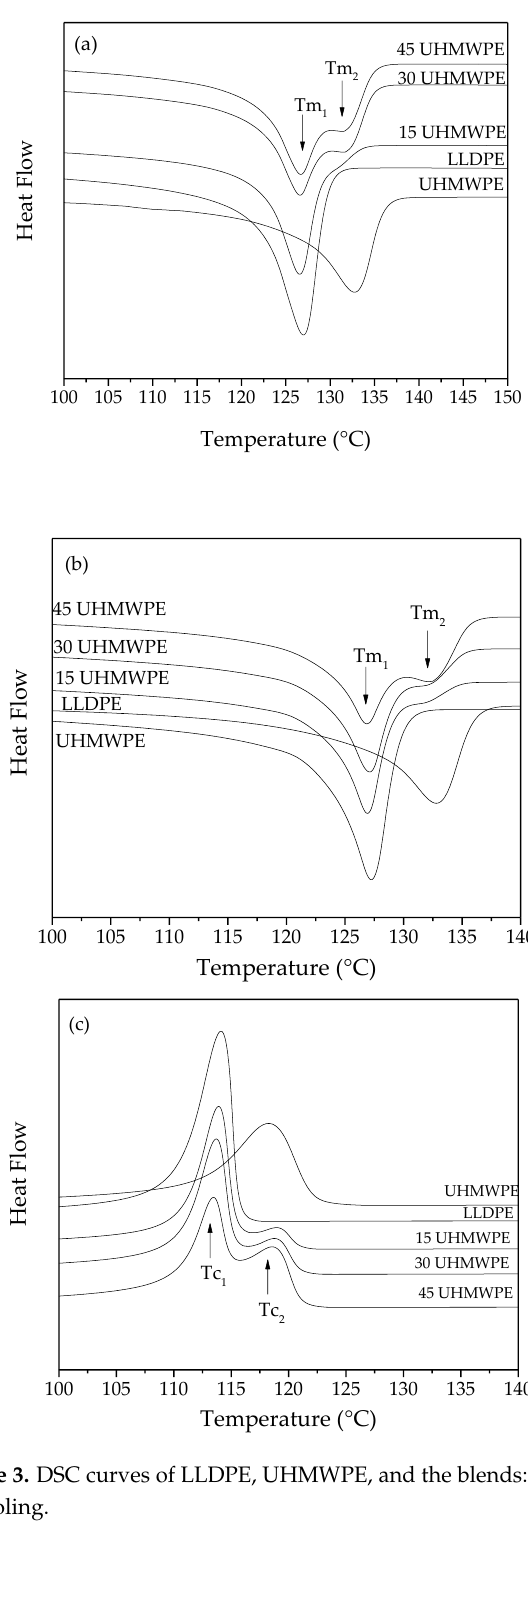
Table 1. Thermal behavior data of LLDPE, UHMWPE, and blends for first heating and cooling. Formulation